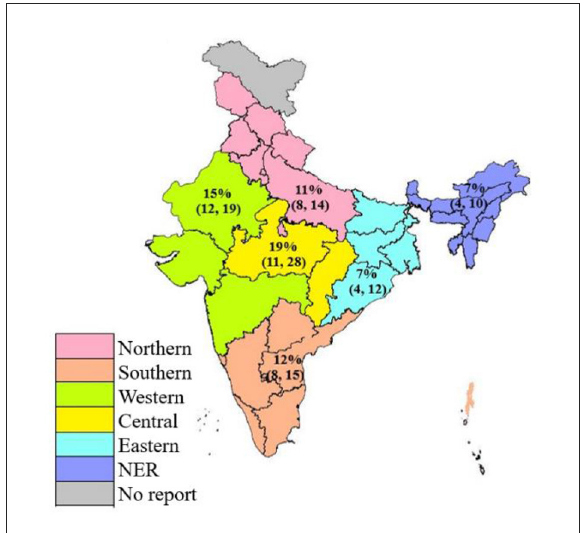
FIGURE3 Map showing the pooled prevalence of Brucellosis in different regions of India.